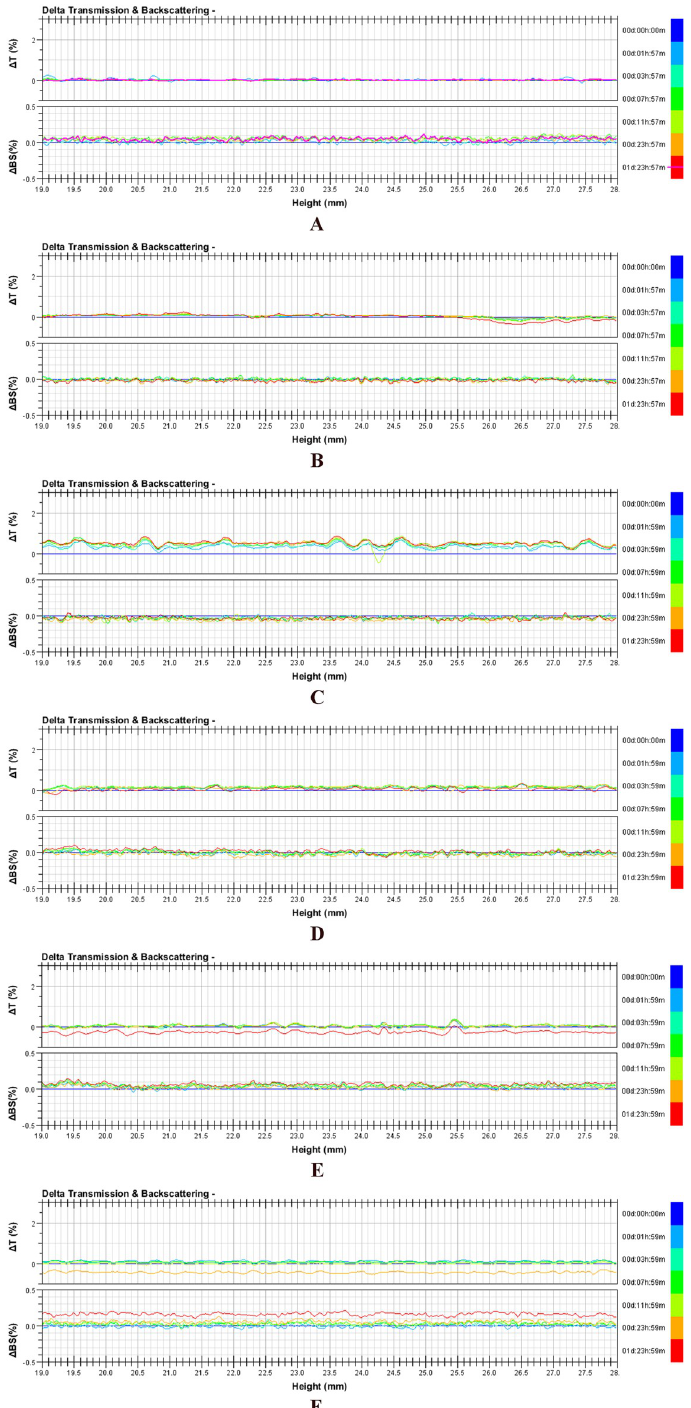
Fig 7. Variation profiles of transmission and backscattering for self-made nanoparticles, Abraxane, and their dilutions at 37˚C. (A) Self-made nanoparticles at a paclitaxel concentration of 5mg/mL. (B) Self-made nanoparticles diluted 100-fold with physiological saline. (C) Self-made nanoparticles diluted 100-fold with MEM culture media containing 10% FBS. (D) Abraxane suspension at a paclitaxel concentration of 5mg/mL. (E) Abraxane diluted 100-fold with physiological saline. (F) Abraxane diluted 100-fold with MEM culture media containing 10% FBS.